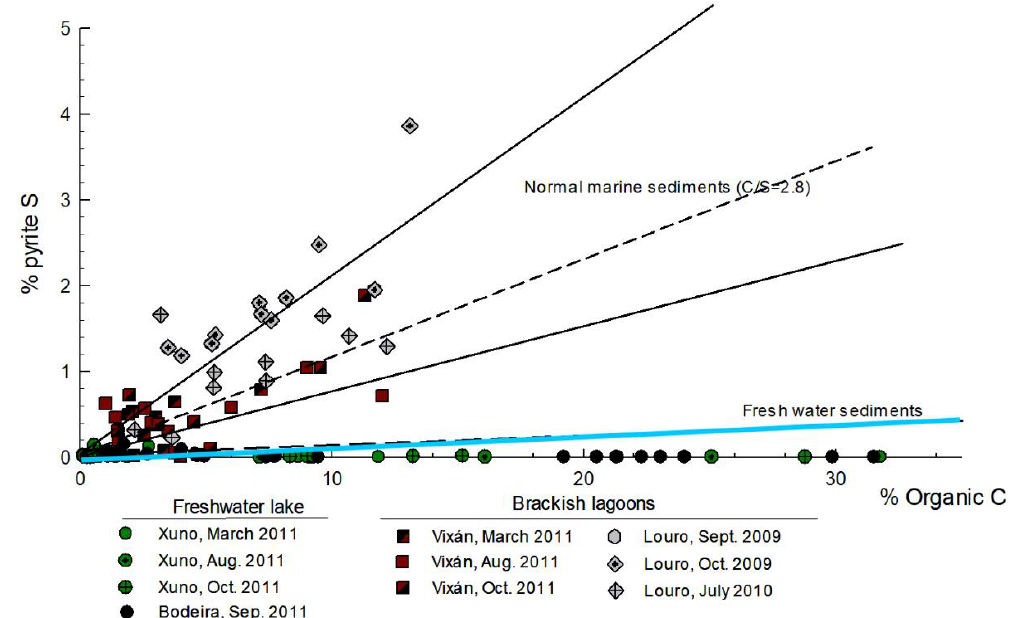
Figure 2. Organic carbon vs pyrite S in lake sediments. Black solid lines represent the typical relation for marine sediments (C / S = 2.8 ± 1.5; [23,36]), while the blue solid line represent the same relation for freshwater environments with a reduce sulphate concentration [22]. For each location, the graph shows the results in surficial and deep samples (up to 100–110 cm in depth). The high relation C / S in all samples indicate that Xuño and Bodeira were always freshwater lakes.